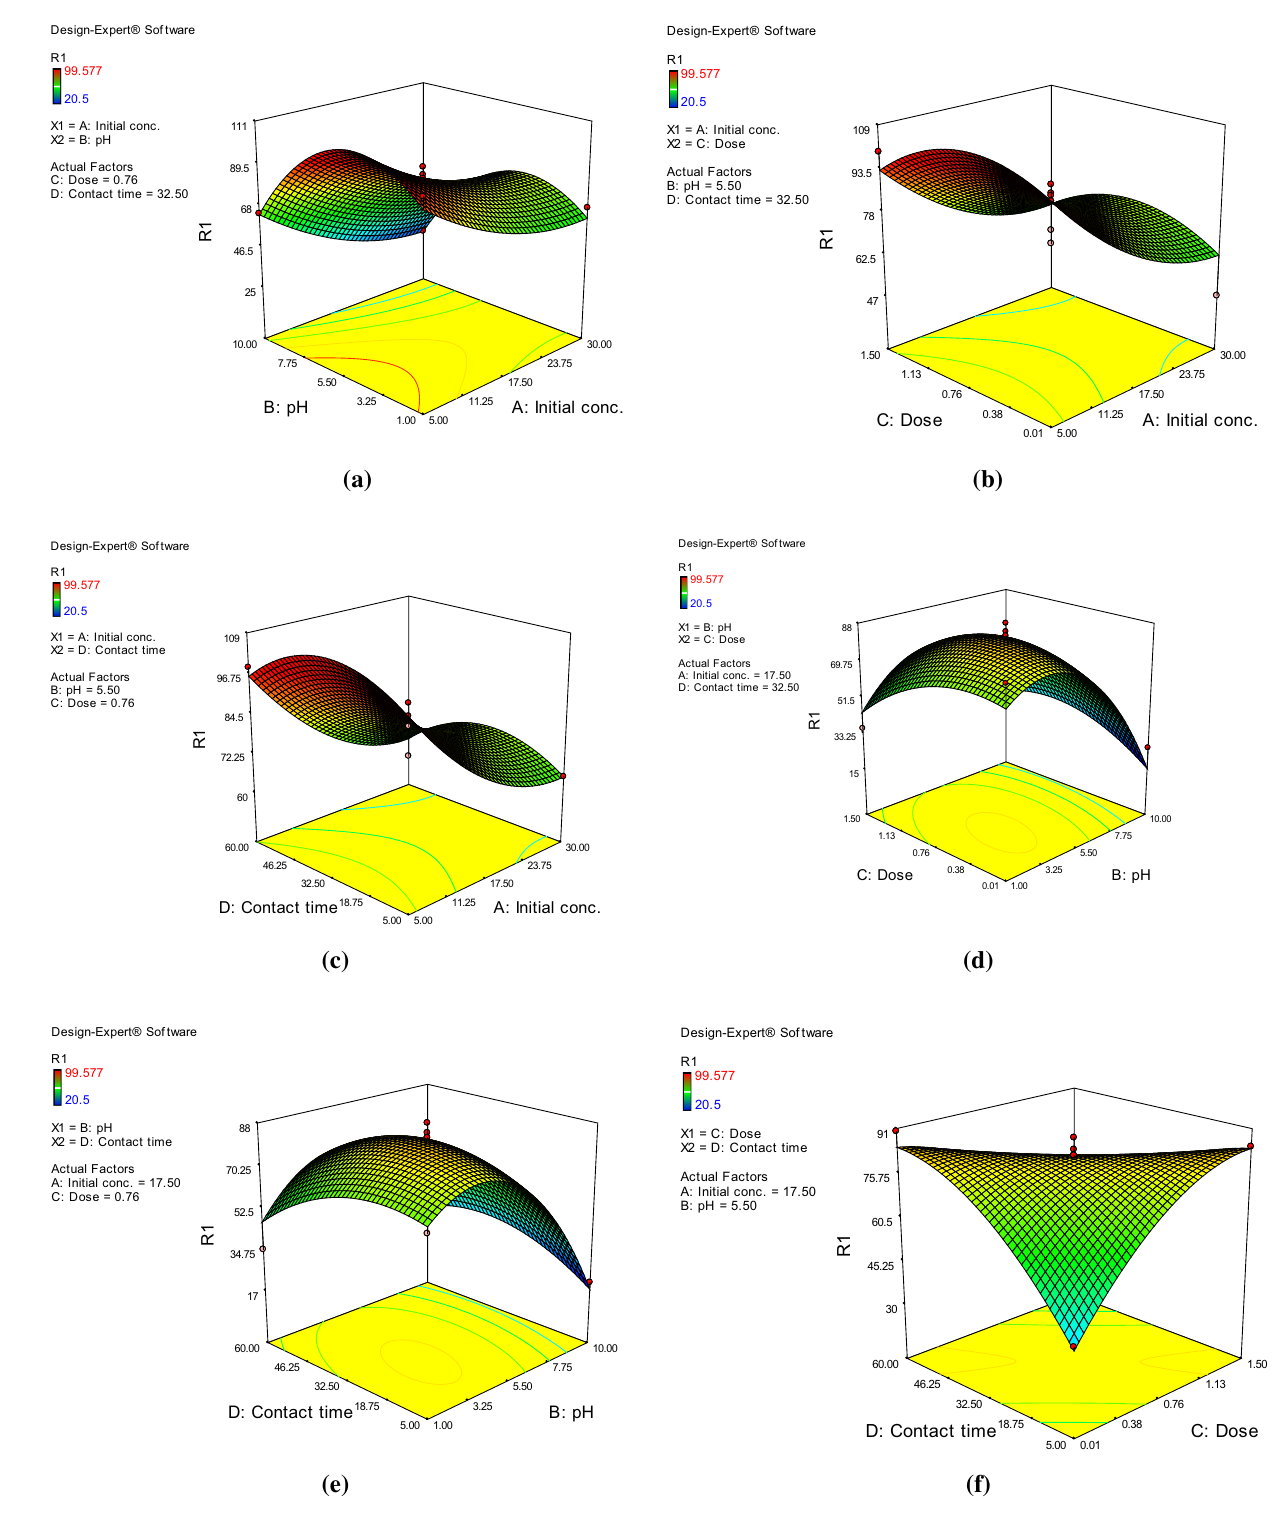
Fig. 10 Response surface plot showing the effect of independent variables for removal of Cr(VI) onto mosambi